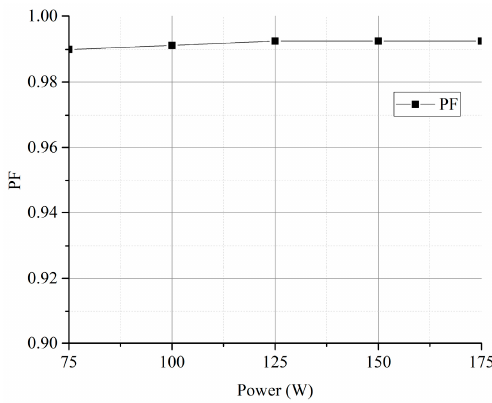
Figure 12. AC–DC DAB efficiency versus output power.